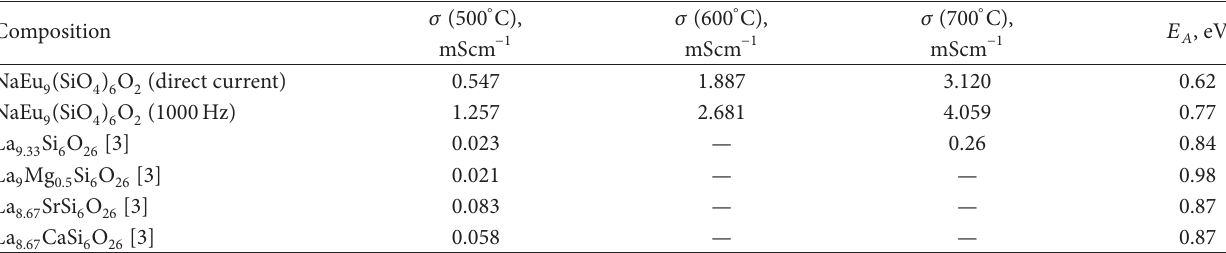
T 4: DC and AC conductivity and activation energy for the samples.